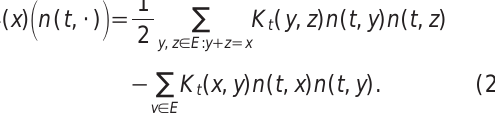
Schematic of processes in nanoparticle flame